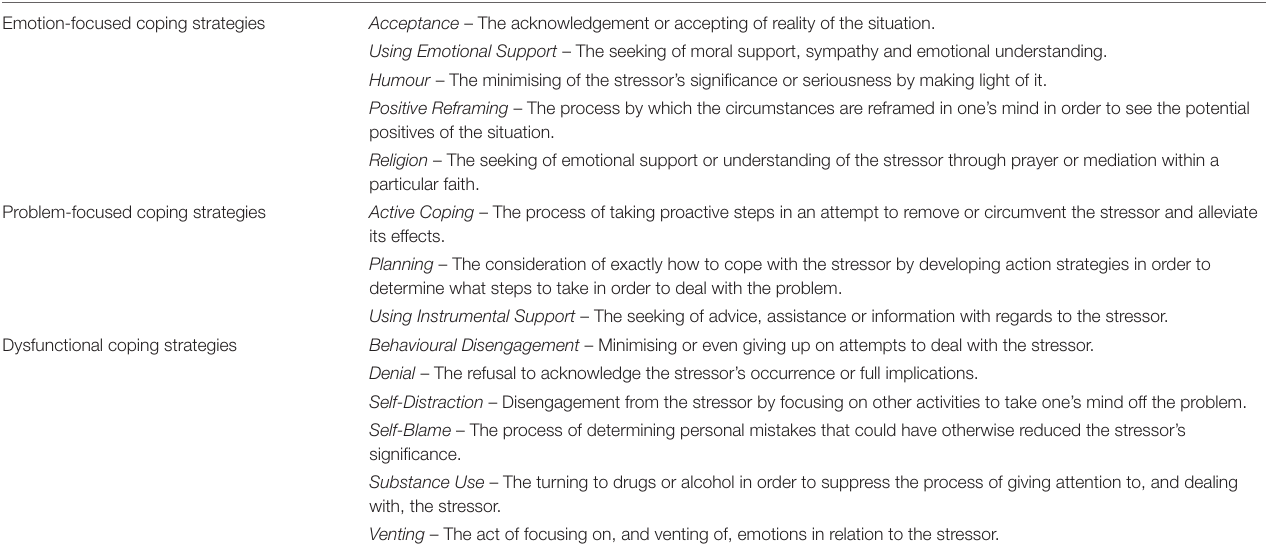
TABLE 1 | COPE strategies by subgroup. Emotion-focused coping strategies Acceptance – The acknowledgement or accepting of reality of the